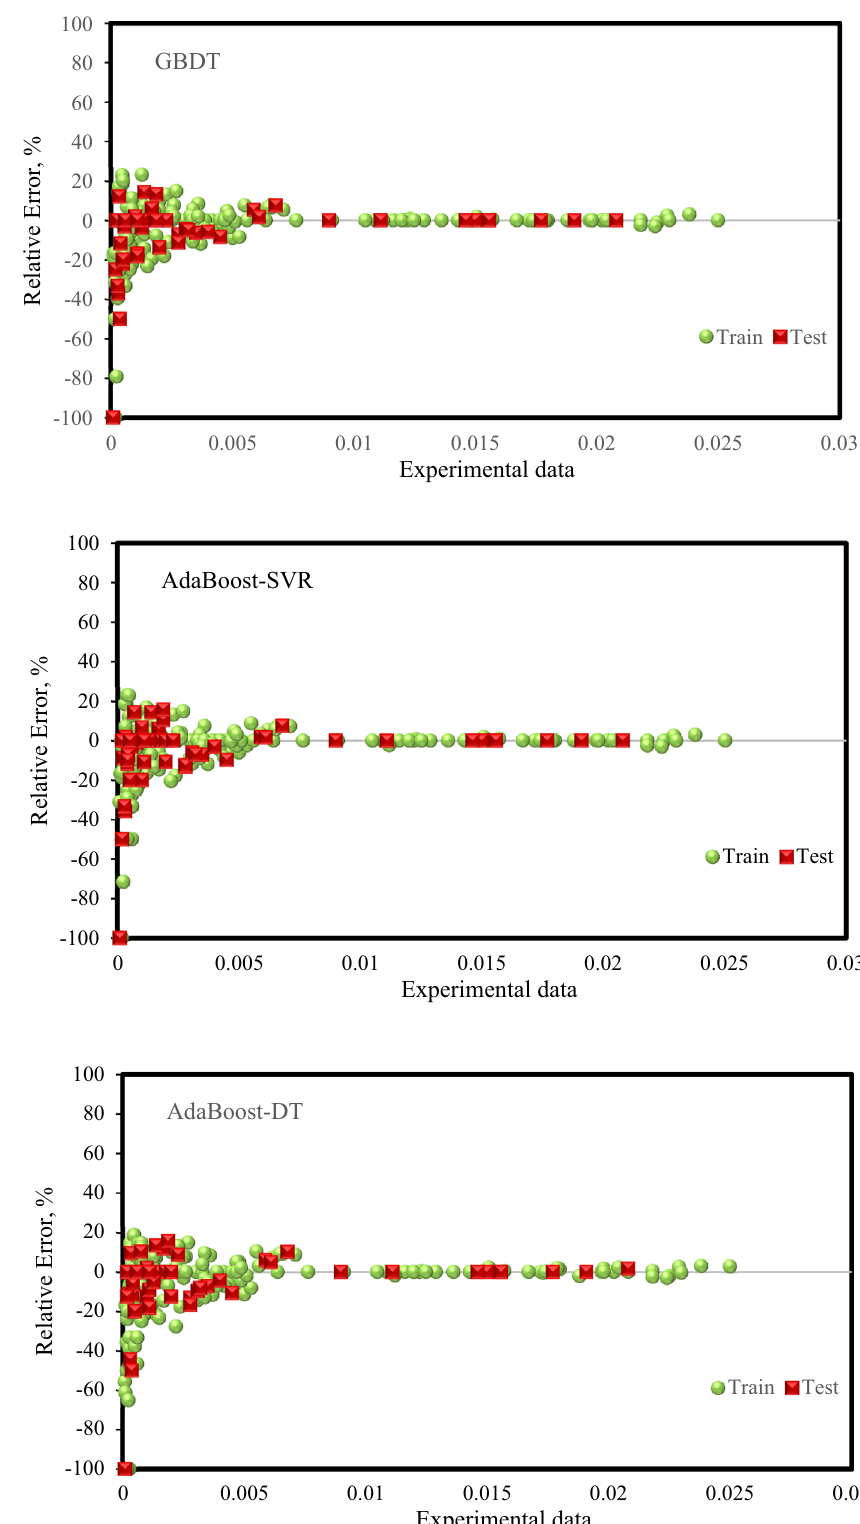
Figure 5. Error distribution plots of the developed models for training and test